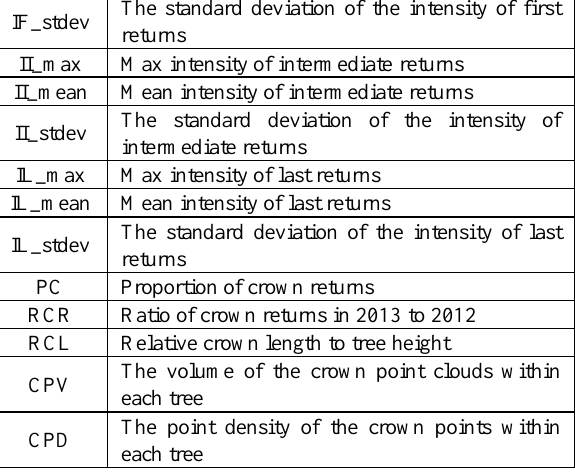
Table 2. Definitions of the 42 point-based features